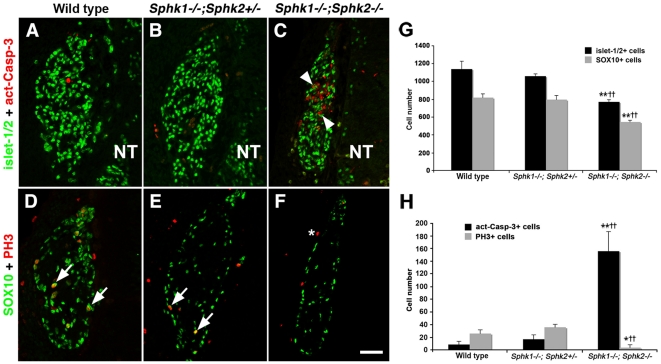
Cell loss in Sphk1−/−;Sphk2−/− becomes apparent in the dorsal root ganglia by E11.5.(A–C) E11.5 DRG section from wild type, Sphk1−/−;Sphk2+/−, and Sphk1−/−;Sphk2−/− embryos immunostained with antibodies to act-Casp-3 (red) and islet-1/2 (green, nuclear). Very few act-Casp-3+ cells can be observed in wild type (A) and Sphk1−/−;Sphk2+/− (B) while Sphk1−/−;Sphk2−/− (C) shows significant cell death (arrowhead). (D–F) Adjacent sections to those in (A–C) were stained with anti-PH3 (red) and SOX10 (green). Both wild type (D) and Sphk1−/−;Sphk2+/− (E) DRG display PH3+ cells and some of them are also SOX10+ (arrow). Sphk1−/−;Sphk2−/− DRG (F) is smaller and has fewer PH3+ cells (red). (G) Quantification of total cell number shows that Sphk1−/−;Sphk2−/− DRG have significant loss (>30%) in both neurons (black bars) and progenitor cells compare to wild type and Sphk1−/−;Sphk2+/−. n = 3 embryos from each genotype; ** = Sphk1−/−; Sphk2−/− to wild type comparison, p<0.01. †† = Sphk1−/−; Sphk2−/− to Sphk1−/−;Sphk2+/− comparison, p<0.01. (H) Wild type and Sphk1−/−;Sphk2+/− DRG have fewer than 20 act-Casp-3+ dying cells on average but Sphk1−/−;Sphk2−/− double mutants have an average of 156 dying cells. Cell proliferation is modest in E11.5 wild type and Sphk1−/−;Sphk2+/− DRG but is further reduced in the double mutant. n = 3 embryos from each genotype; * = Sphk1−/−;Sphk2−/− compare with wild type, p<0.05; ** = Sphk1−/−;Sphk2−/− to wild type comparison, p<0.01. †† = Sphk1−/−;Sphk2−/− to Sphk1−/−;Sphk2+/− comparison, p<0.01. NT = neural tube. Scalebar for A–F = 50 µm.